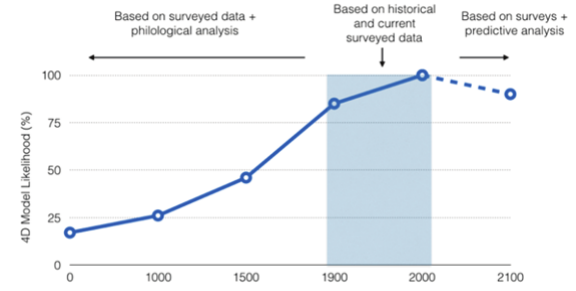
Figure 1. Three cases of time-dependent 3D analysis covered within the framework of the analysis of our legacy through